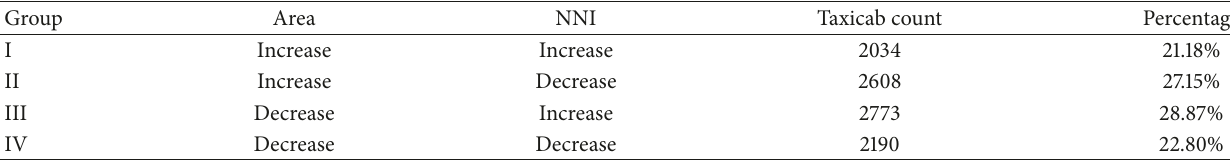
Figure 3: Distributions of the unweighted repetition ratio (a) and weighted repetition ratio (b) between different neighboring periods. Table 2: Grouping result of